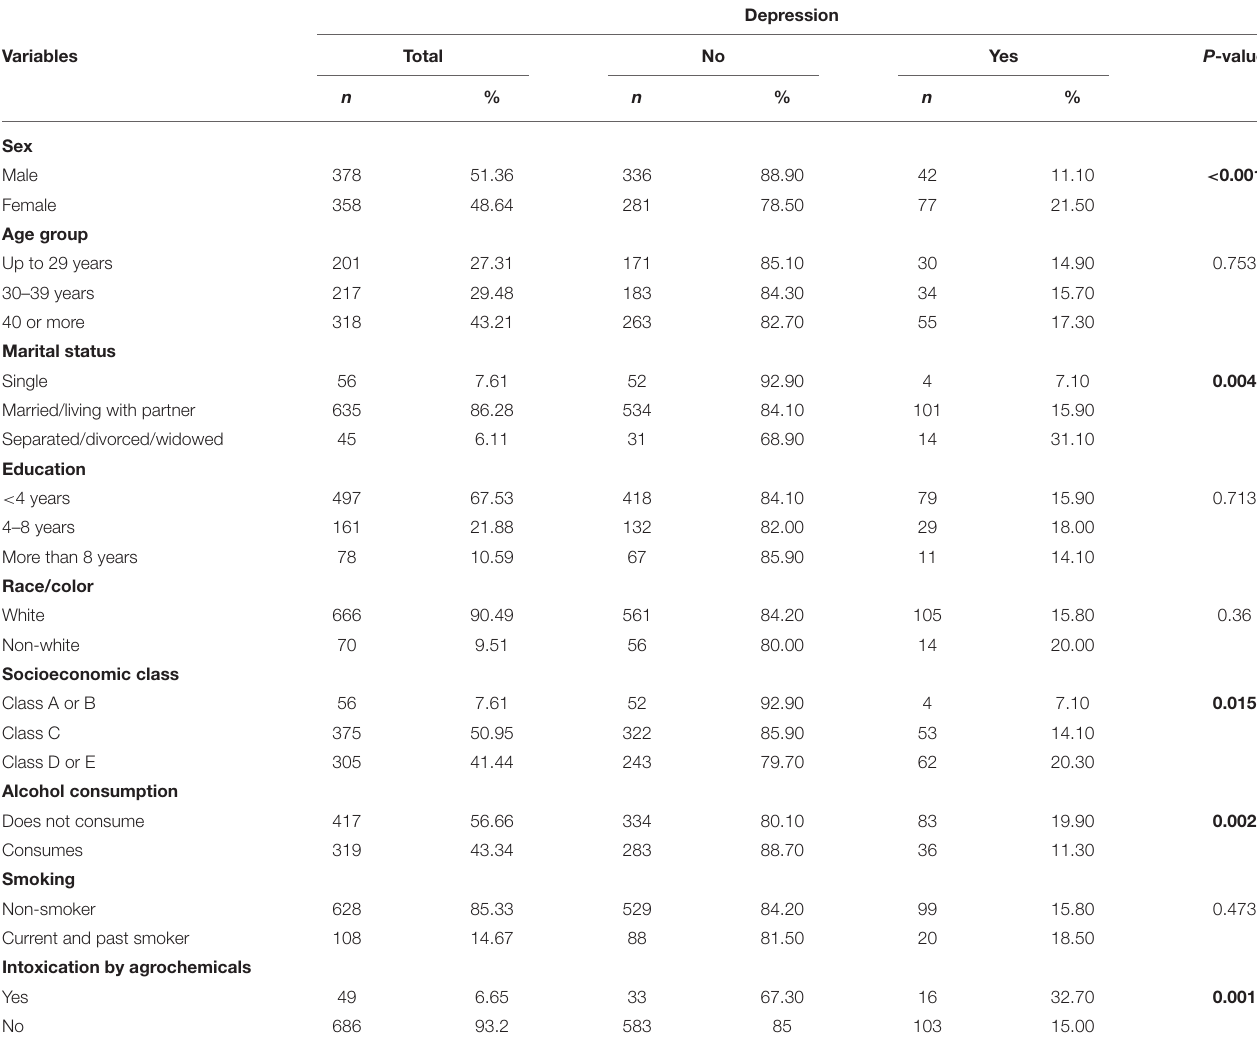
TABLE 1 | Prevalence of depression according to sociodemographic characteristics, lifestyles, and pesticide intoxication among Brazilian farmers.